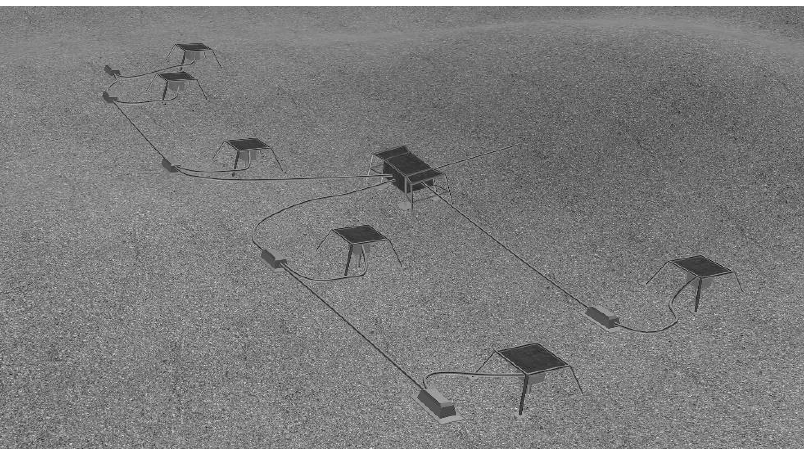
Figure 1. Subsea production system (SPS) .